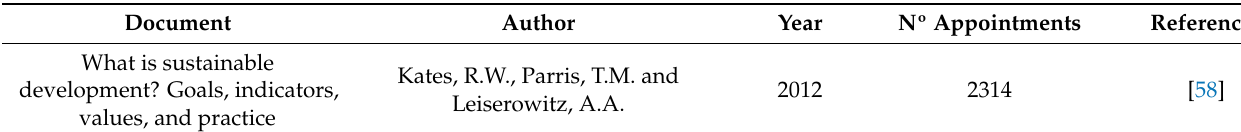
Table 2. Most-cited documents.